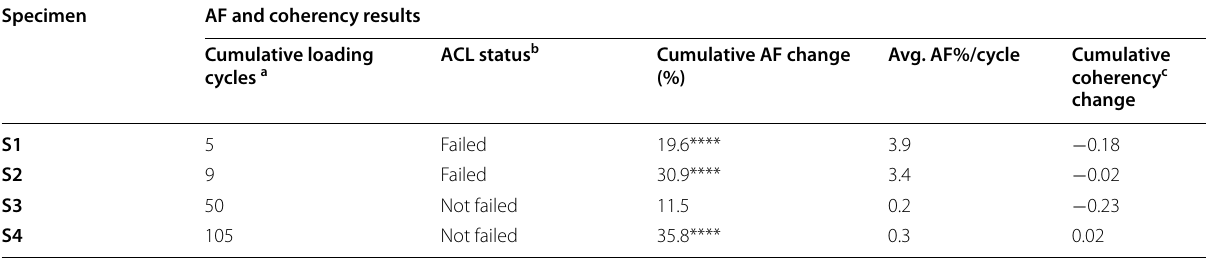
a Including pre-loading cycles b Determined by cumulative ATT threshold of 3 mm sustained by ACL at the end of fatigue loading c Coherency values range from